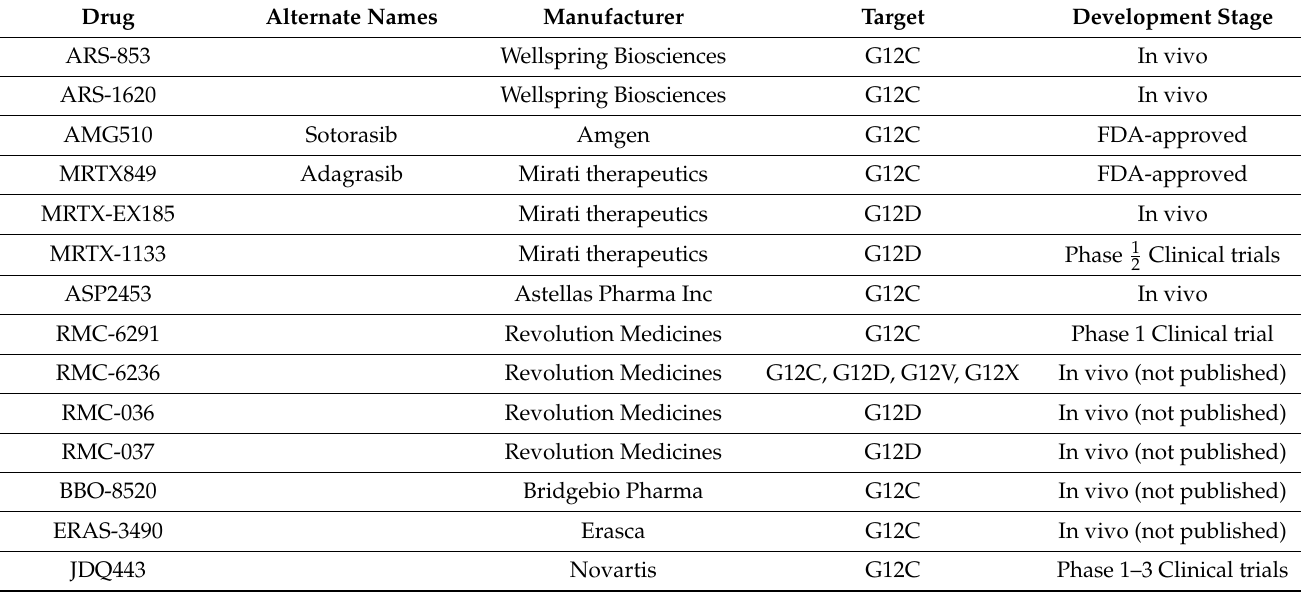
Table 1. Current direct KRAS-mutant